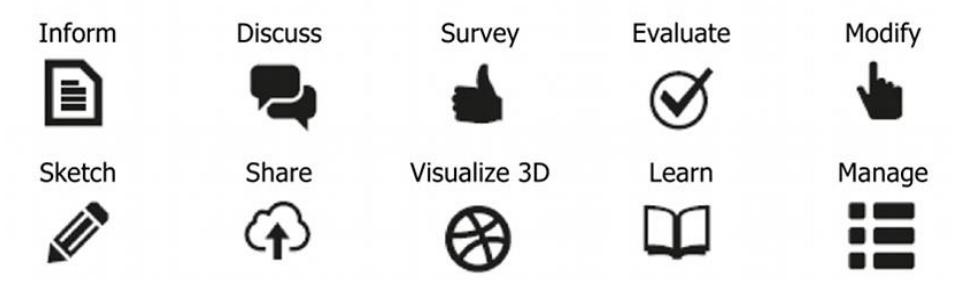
Figure 2. Proposed planning support functionality for e -planning